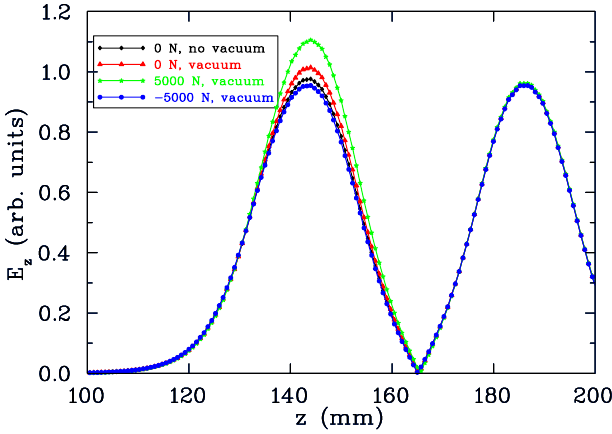
FIG. 42. (Color) Simulated influence of the external vacuum pressure and of the external force of the tuner on the electric field distribution.